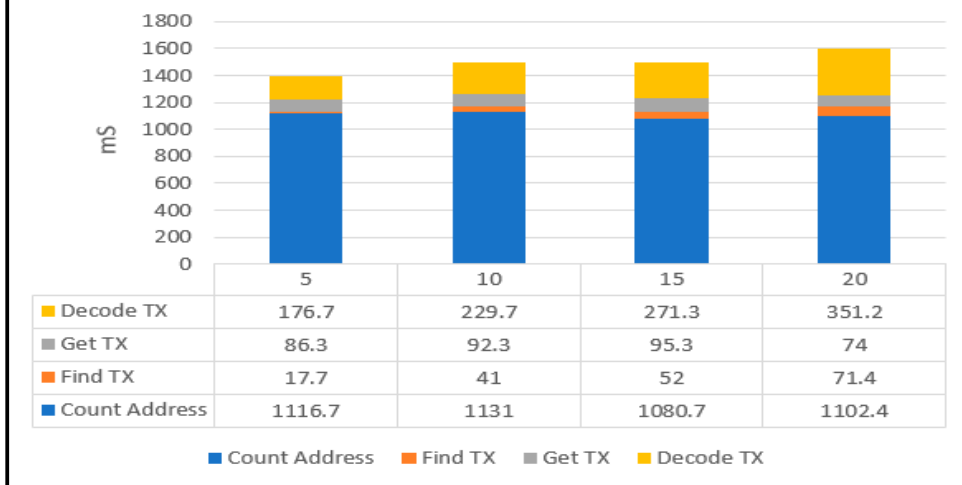
Figure 15. Cost of fetching and analyzing transaction .